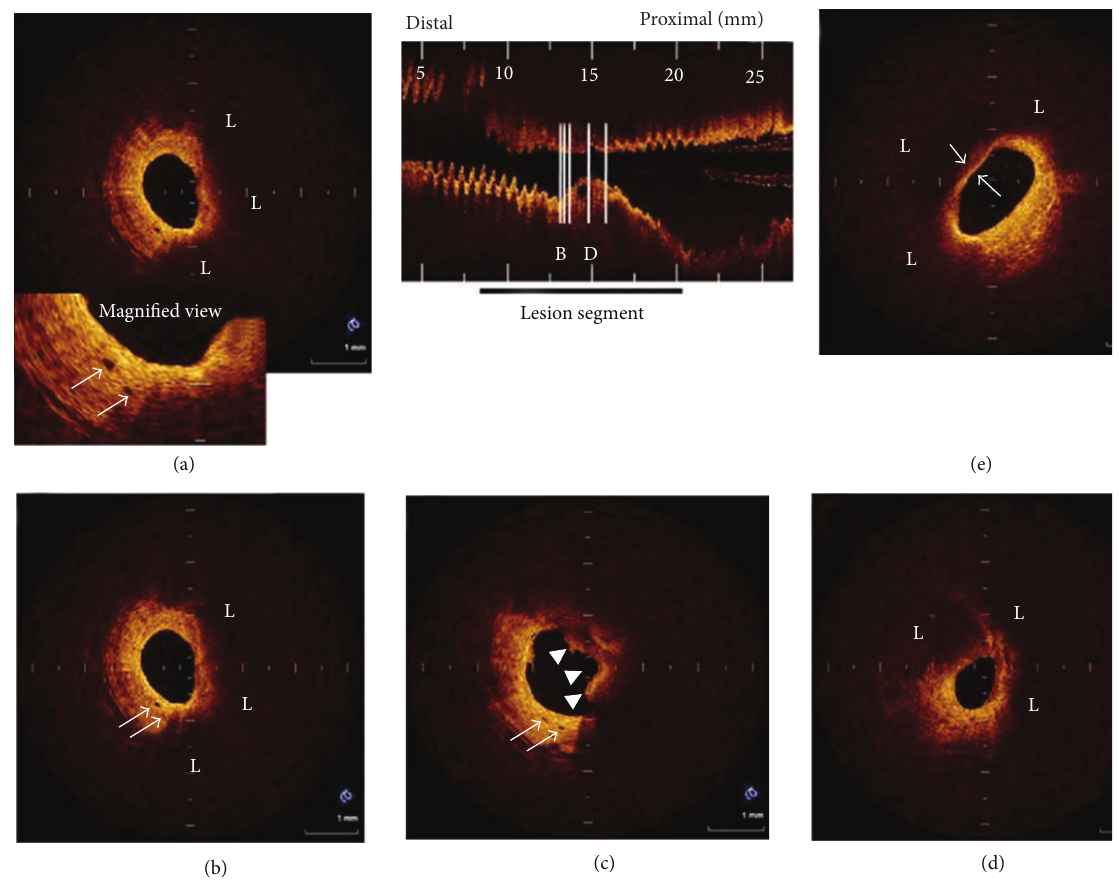
Figure 4: Representative OCT images of coronary plaque with microchannels. (a), (b) Two consecutive cross-sectional OCT images. Eccentric lipid-rich plaque (L) was imaged. Two microchannels (arrow) were located in thickened intima at shoulder region of plaque. (c) Proximal site adjacent to plaque imaged in Figures (a) and (b) . Two microchannels (arrow) were located in thickened intima at 7-o’clock position. Intracoronary thrombus (arrowhead) was also visualized. (d) Minimum lumen area site. Lipid-rich plaque was visualized. (e) Lipid- rich plaque covered by thin fibrous cap (50 𝜇 m) imaged and found to be thin cap fibroatheroma. Reprint with permission from